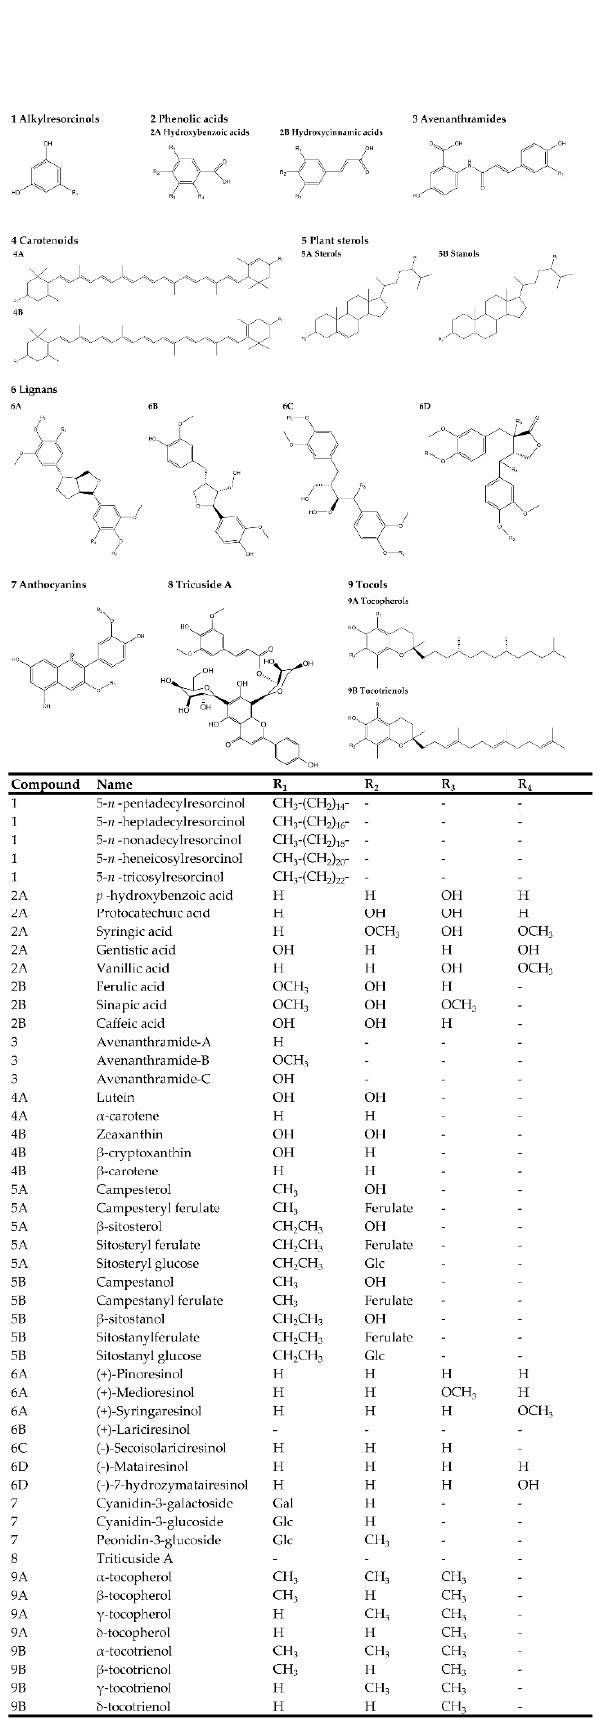
Figure 1. Major bioactive phytochemicals derived from whole grains.